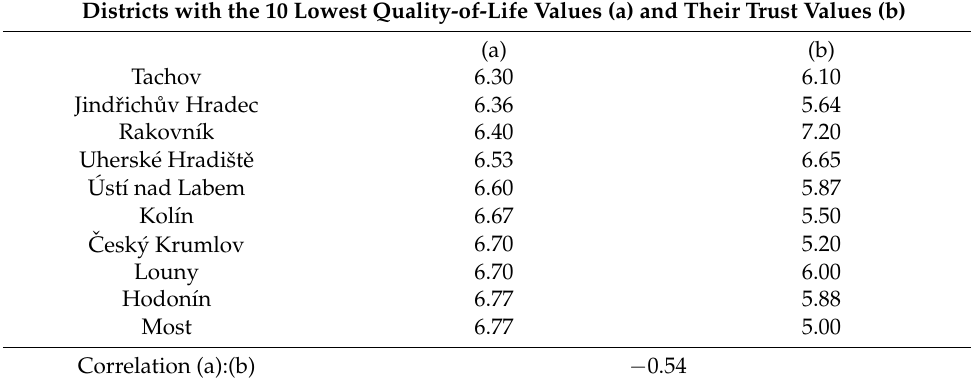
Table 6. Districts with the lowest quality of life and corresponding trust values. Districts with the 10 Lowest Quality-of-Life Values (a) and Their Trust Values (b)